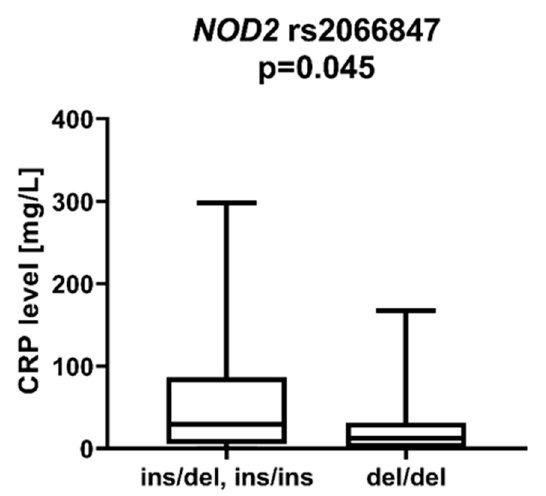
Figure 7. CRP level in patients with and without rs2066847 insertion in NOD2 gene.